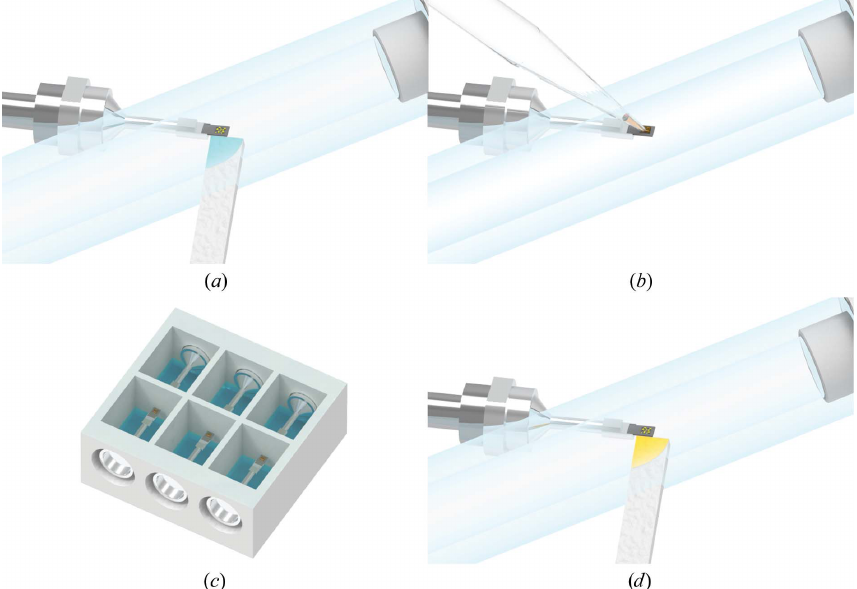
Figure 5 Procedure for on-chip ligand-soaking experiments. ( a ) Crystals are either grown on Roadrunner I chips or 1–3 m l of batch-grown crystals are applied to the chip. Under a stream of humidified air, the mother liquor is removed from the chip through the pores. ( b ) 2–3 m l of ligand-soaking solution is applied to the crystals. ( c ) One well of the crystallization chamber is filled with the appropriate reservoir solution. The chip is installed in the crystallization chamber and incubated for the desired time period. ( d ) The soaking solution is removed through the pores of the chip and crystals are either measured at room temperature or the chip is cooled in liquid nitrogen for cryogenic data collection.